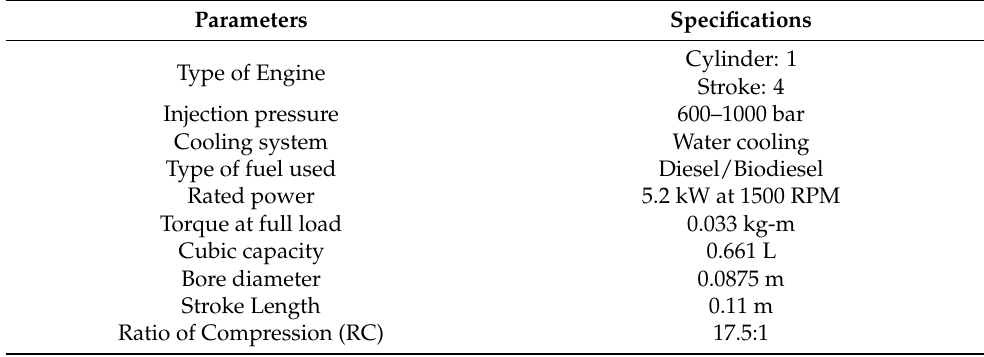
Table 3. Specifications of CRDi Diesel